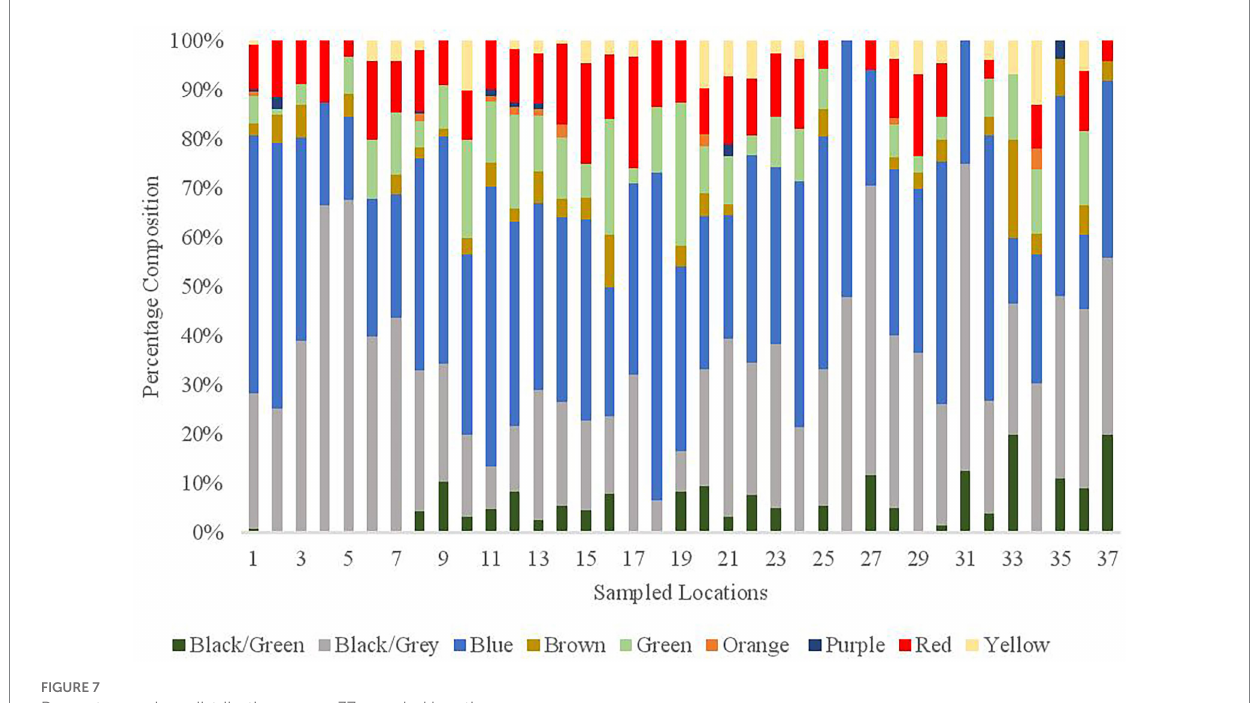
FIGURE 7 Percentage colour distribution across 37 sampled locations.